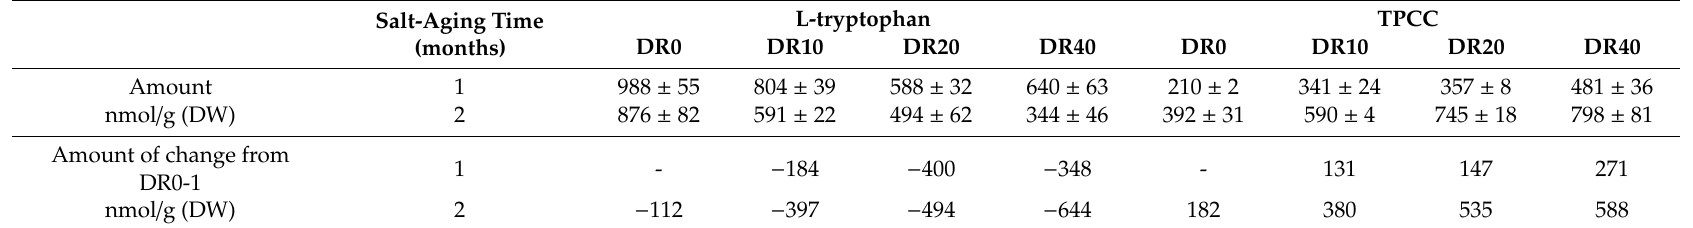
Table 1. Tryptophan and TPCC content, and their variation in hoshi